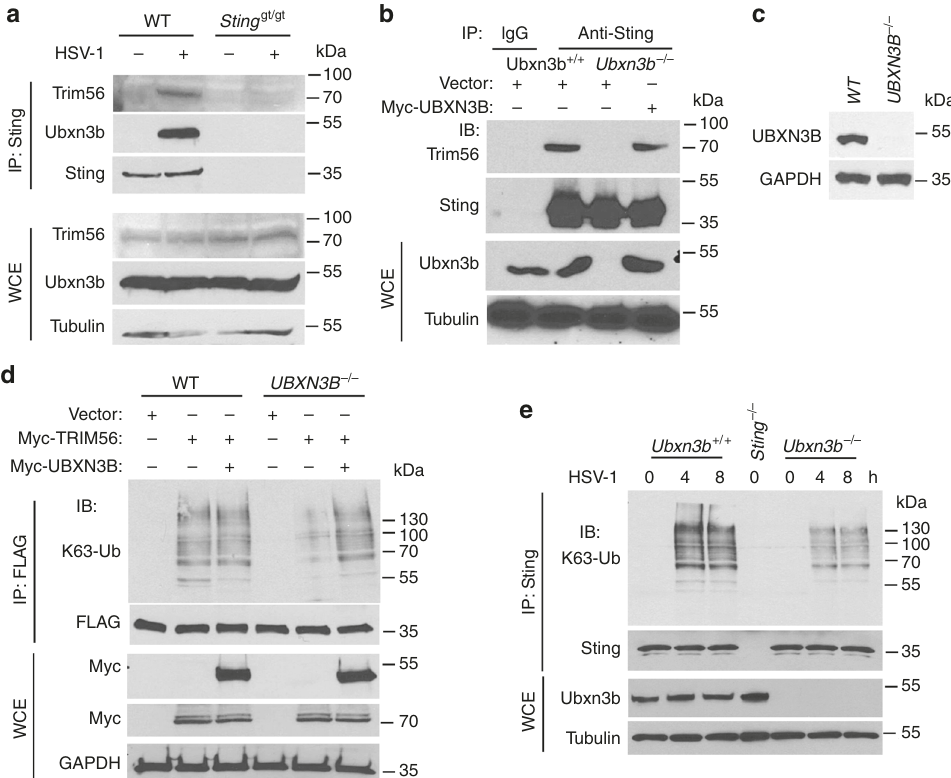
Fig. 6 UBXN3B mediates STING interaction with and ubiquitination by TRIM56. a WT and Sting gt/gt MEFs were infected with or without HSV-1 (MOI = 0.5) for 8 h. Sting was immunoprecipitated (IP) from the MEF lysates using a rabbit anti-Sting antibody. The immunoblots indicate Sting co-immunoprecipitation with Ubxn3b and Trim56 after viral infection. WCE whole-cell extract. b WT and Ubxn3b − / − MEFs were transfected with vector or FLAG-UBXN3B plasmids by electroporation, and then infected with HSV-1 (MOI = 0.5) for 8 h. Sting IP was performed as in a . Rabbit IgG was used as a negative control. c The immunoblots show knockout ef fi cacy of UBXN3B in HEK293T-STING cell line. d WT and UBXN3B − / − cells (parent cell line is HEK293T-FLAG-STING) were transfected with the indicated combinations of plasmids. FLAG-STING was immunoprecipitated (IP) with anti-FLAG magnetic beads. The proteins in IP and WCE were immunoblotted by an anti-K63-linked polyubiquitin, anti-Myc (UBXN3B and TRIM56) and anti-FLAG (STING) antibody, respectively. e Sting was precipitated with a rabbit anti-Sting antibody from cDCs infected without or with HSV-1 (MOI = 10) for 4 and 8 h. The Sting − / − cDCs were used as an IP control. The proteins in IP and WCE were immunoblotted with an anti-K63 and Sting antibody, respectively. Tubulin and GAPDH are housekeeping controls. The results are representative of two independent